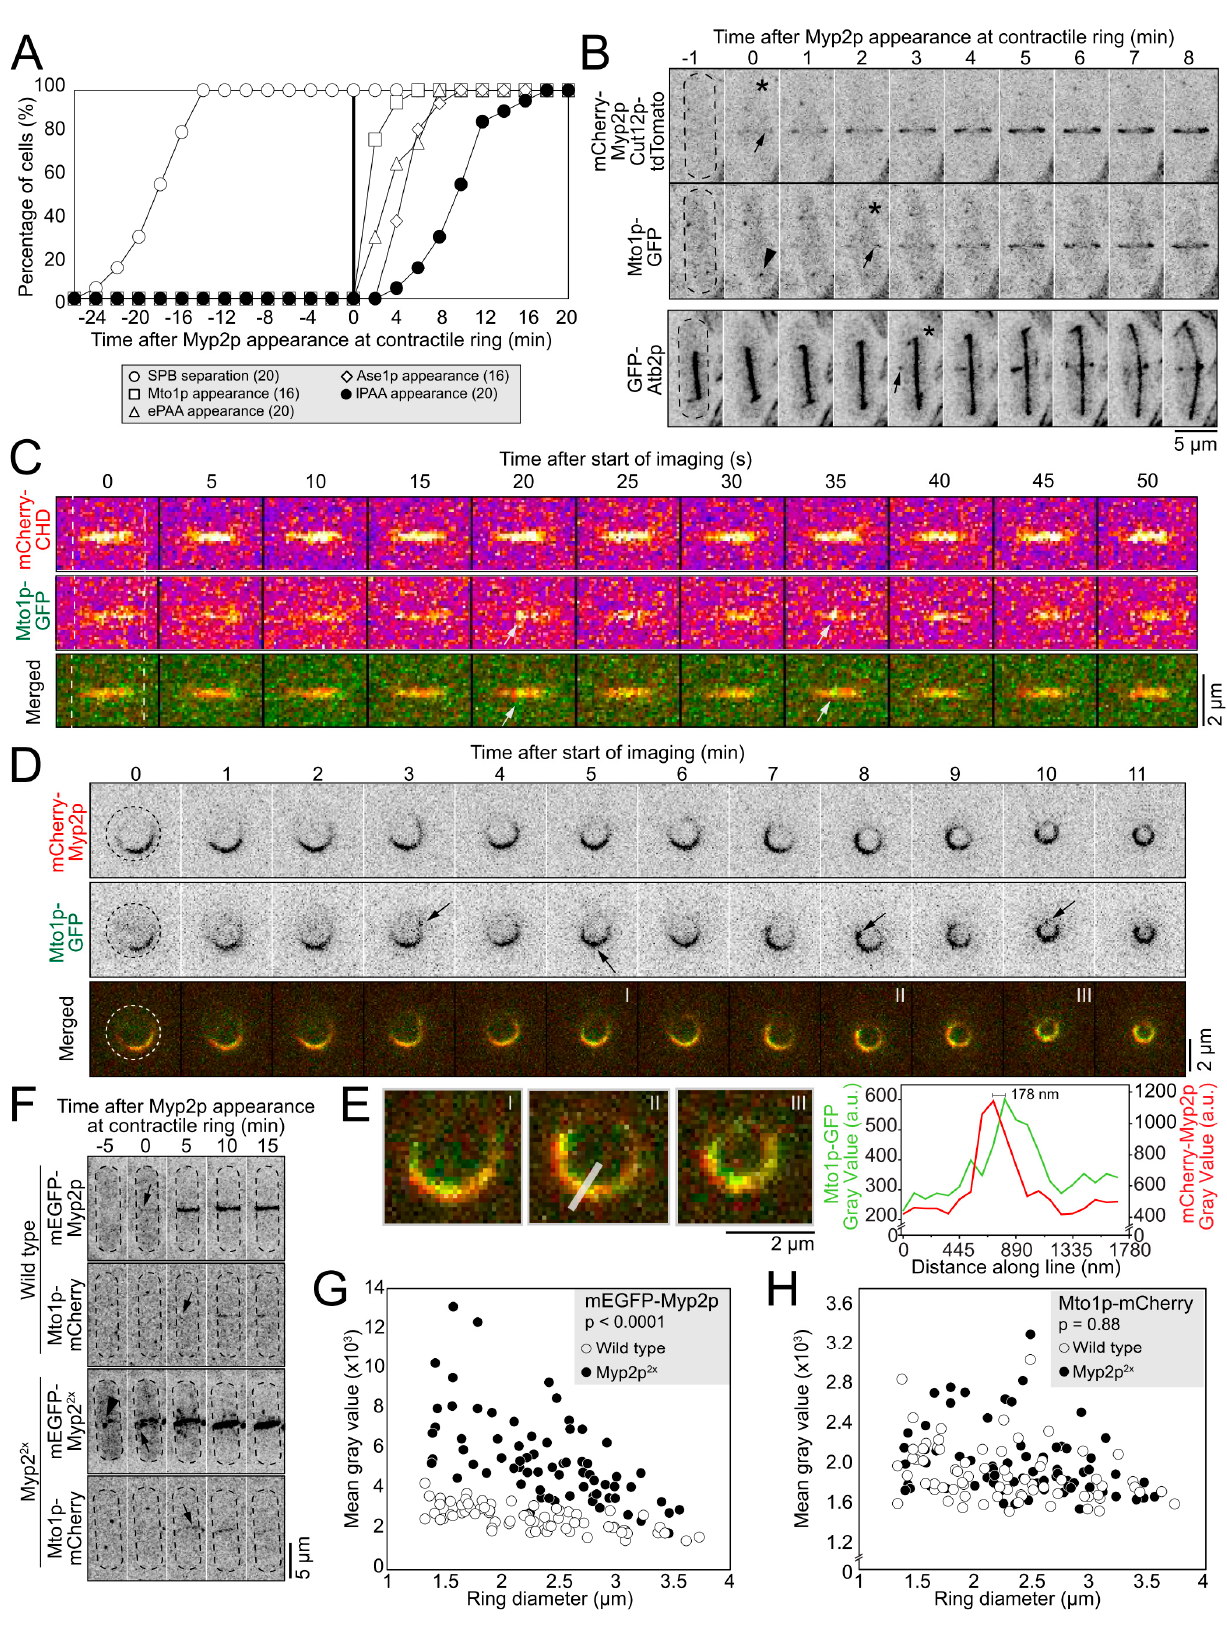
Figure 1. Myp2p facilitates Mto1p recruitment to contractile ring without their direct interaction. ( A ), Outcome plot showing the timing of events leading to the assembly of the post-anaphase array